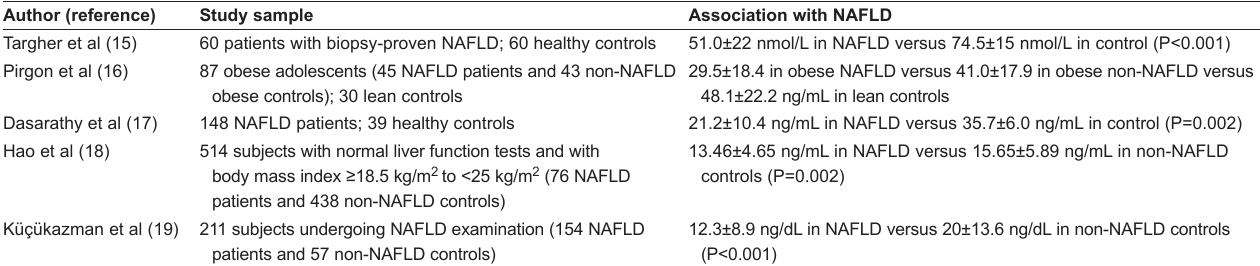
TABlE 1 Mean serum 25-hydroxyvitamin D levels reported in selected